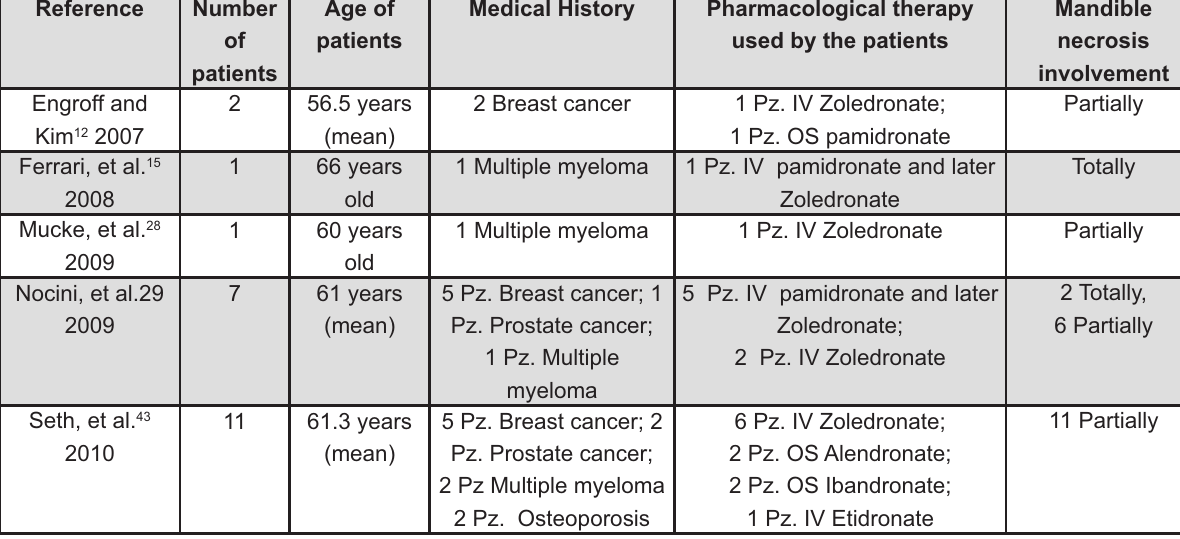
Figure 5- Studies retrieved from the review of the literature: analysis of medical history, type of therapy used and mandible necrosis involved